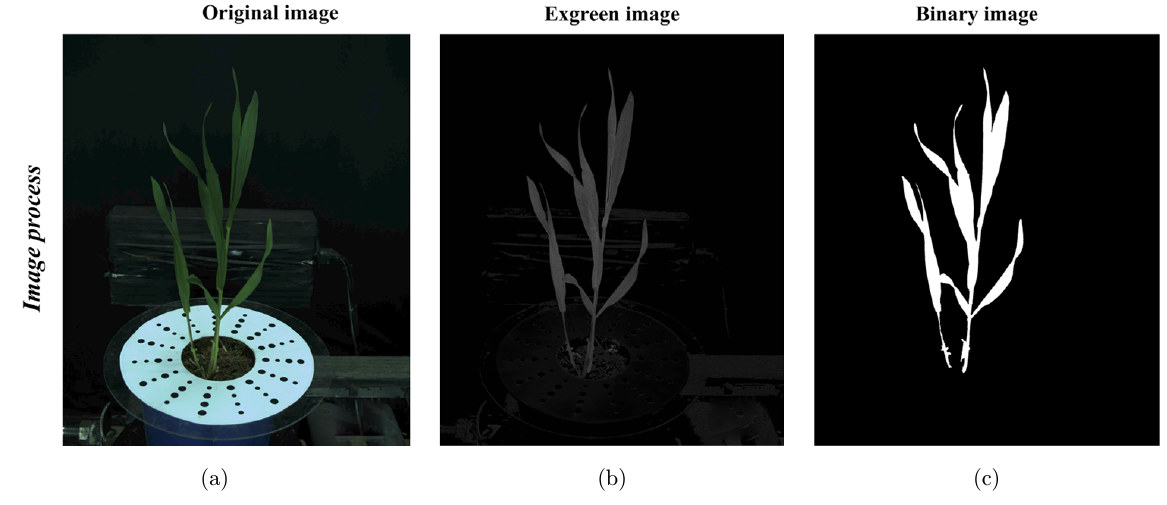
Fig. 3. The image processing procedure used to obtain the